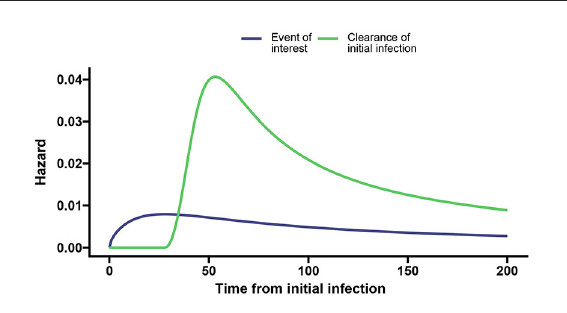
FIGURE3 Baseline hazards for the event of interest (blue) and clearance of the initial infection without the event of interest (green) with the dashed vertical lines indicating the time associated with the peak hazard for the event of interest and clearance,